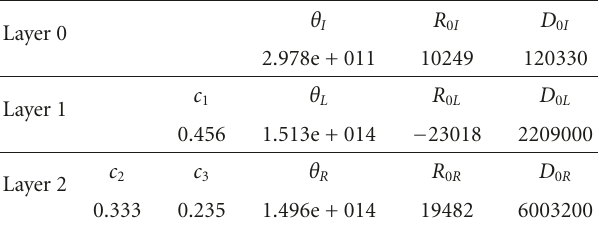
Table 2: Encoder RD curve parameters for “Soccer”